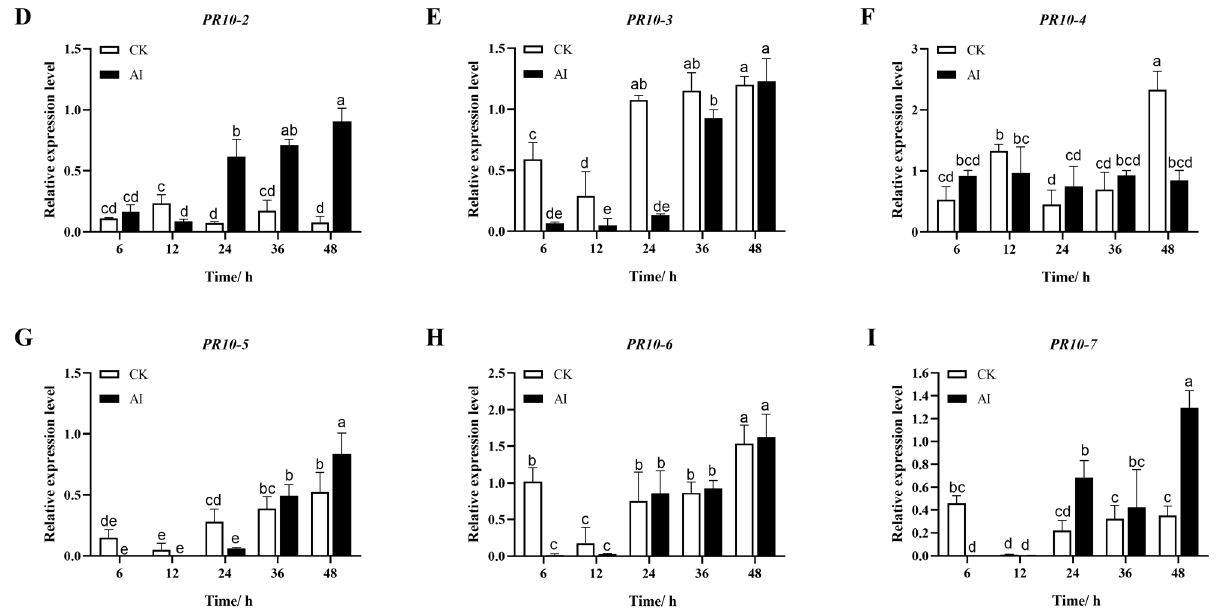
Figure 4. ( A–I ) are a consecutive series of pictures showing time course of the level of the LhSorPR genes in ‘Sorbonne’ after infection with Botrytis elliptica. Data represent the mean of three biological repeats ± SD. Error bars indicate the standard deviation, and the different lowercase letters on the bars indicate the significant differences ( p < 0.05).